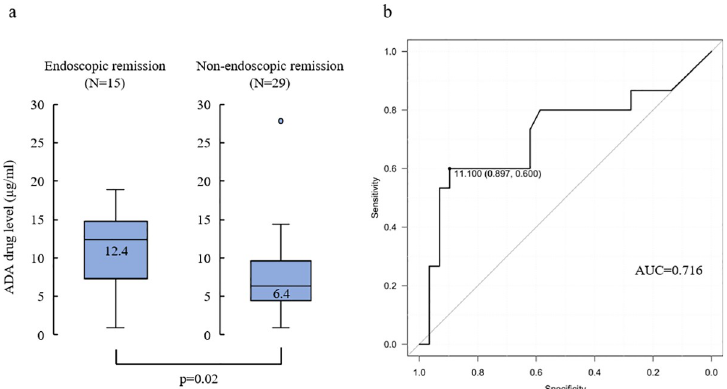
Fig 3. a. Distribution of ADA levels in patients with and without endoscopic remission. Box plots (5%–95%) show the median (solid line within the box), interquartile range (upper and lower box boundaries), and standard deviation (whiskers). There was a significant difference in the ADA level between patients with and without endoscopic remission ( P = 0.02 by Mann–Whitney U test). b. Receiver operating characteristic curve analysis for ADA level stratifying patients with and without endoscopic remission. AUC, area under the curve; ADA, adalimumab.